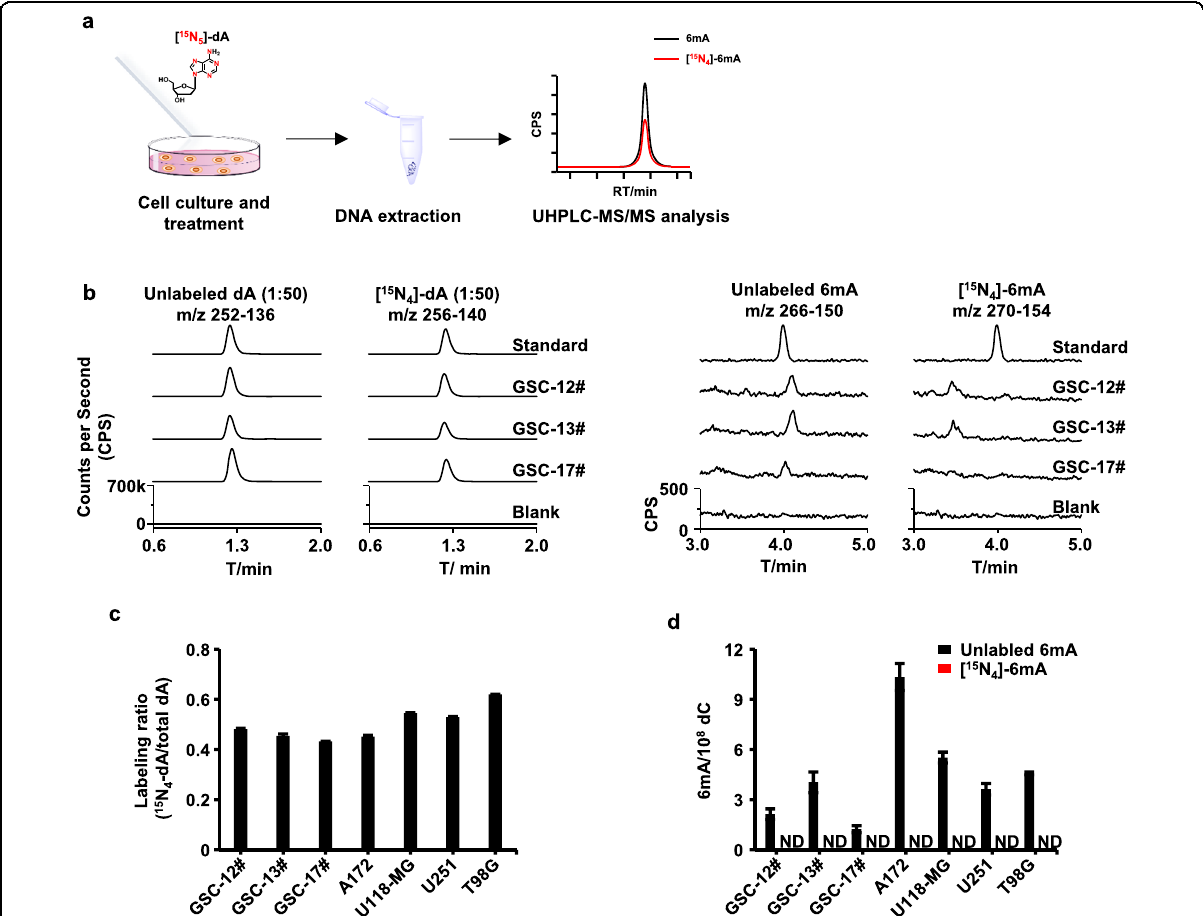
Fig. 2 Characterization of DNA 6mA in GSCs and glioblastoma cell lines by heavy stable isotope tracer [15N5]-dA. a Flow diagram of tracing methylase-deposited DNA 6mA in glioma cells by [ 15 N 5 ]-dA. b UHPLC-MS/MS chromatograms of the labeled dA and 6mA in the genome of glioma stem cells (GSCs). c , d Quanti fi cation of the labeled dA ( c ) and 6mA ( d ) in the genomic DNA of human GSCs and human glioblastoma cell lines. ND, not